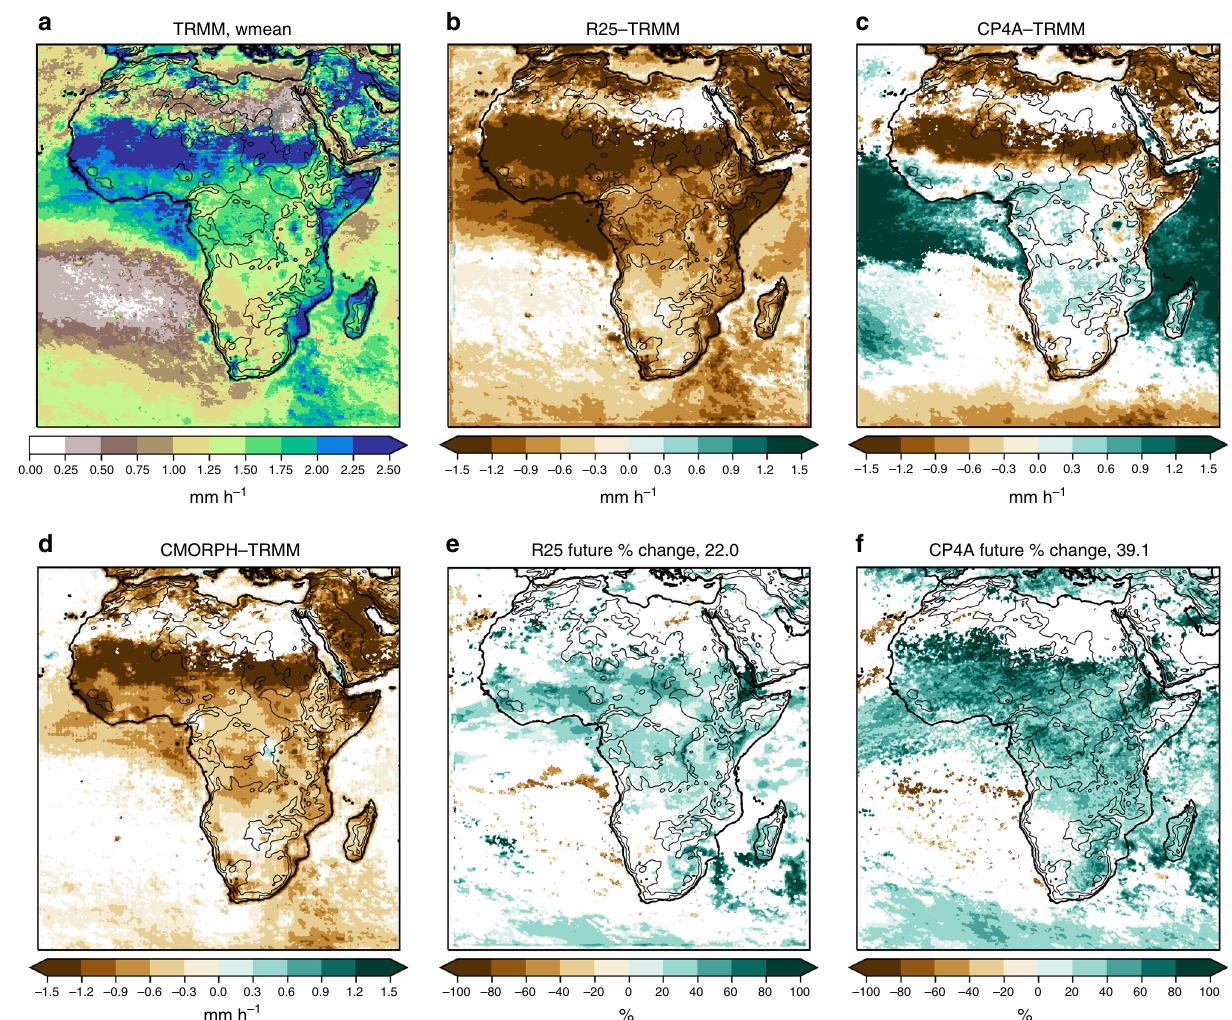
Fig. 4 Wet season mean 3-hourly precipitation intensity. a TRMM observations, differences with respect to TRMM for b the R25 model, c CP4A model and d CMORPH observations, and percentage differences between 2100 and present day for e the R25 model and f CP4A model. Mean precipitation intensity is de fi ned as the mean of wet values (>0.1 mm h − 1 ). The median of future percentage changes across Africa (land points only) is indicated in e , f . Dataset differences and future changes are masked in white, where differences are not signi fi cant at the 5% level compared to year-to-year variability. The wet season is the 3-month period with the highest mean precipitation in TRMM, de fi ned on a grid-point basis. The black lines indicate the 500 -, 1000-, 2000-, 3000 - and 4000 -m height